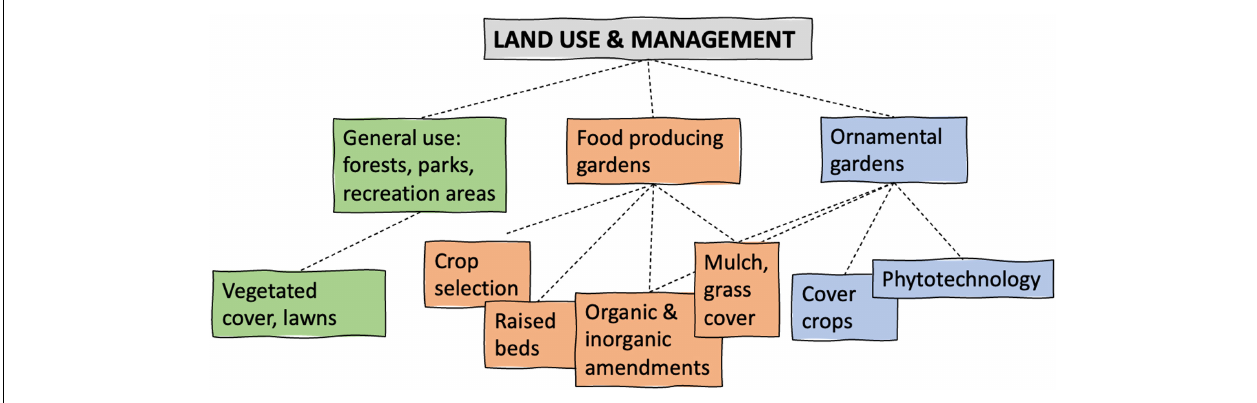
FIGURE 3 | Managing strategies required for different land uses (modified from Vasenev et al., 2017).